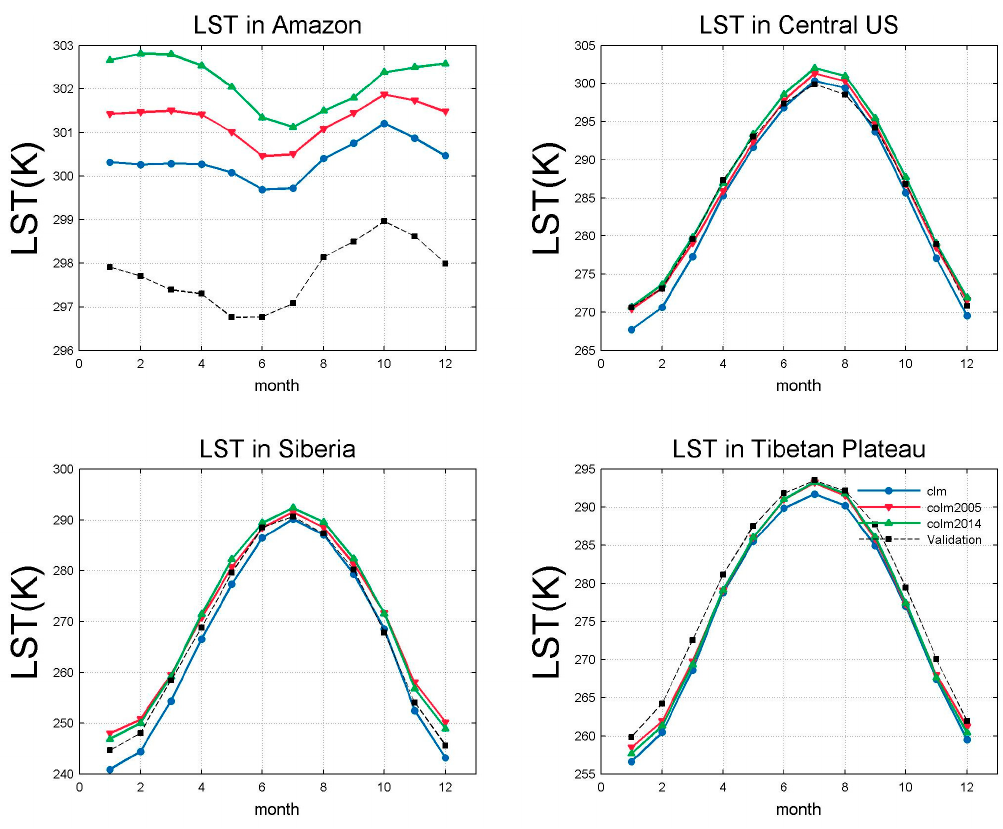
Figure 17. Same as Figure 3, but for land surface temperature (Units: K).